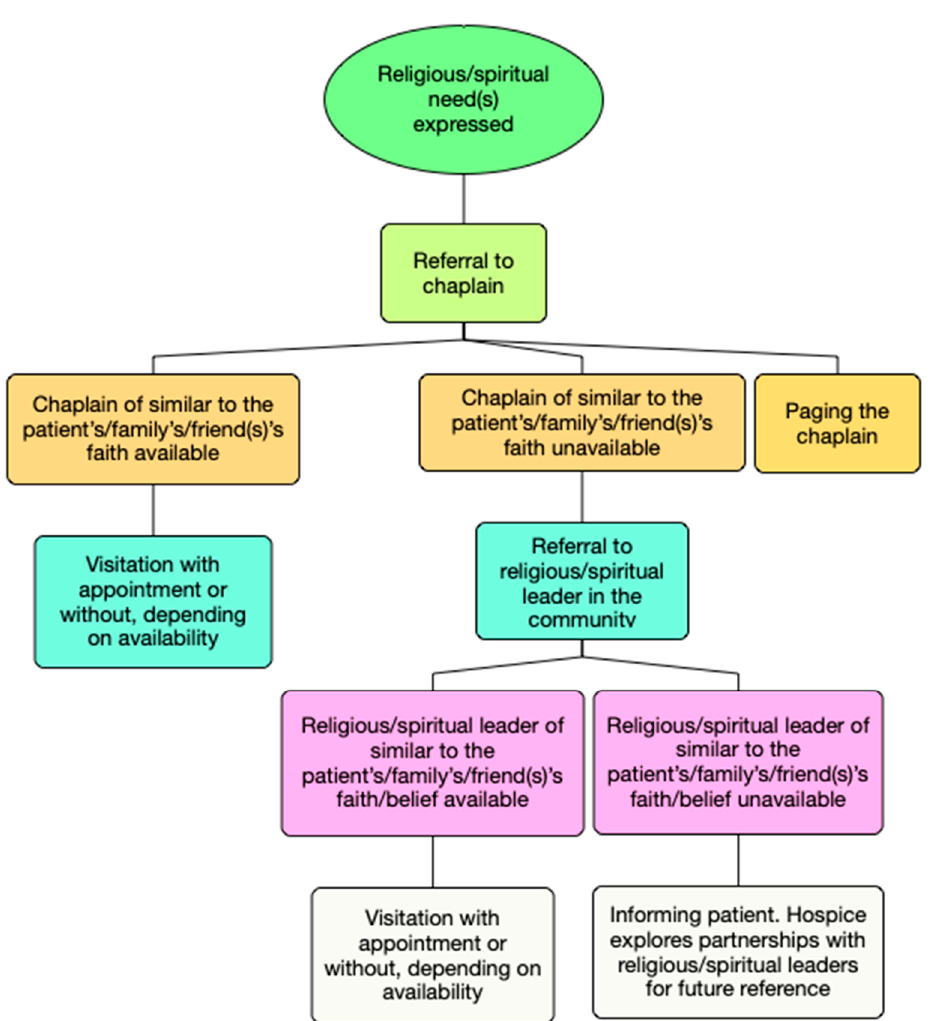
Figure 2. Religious/spiritual referral process in hospice care.